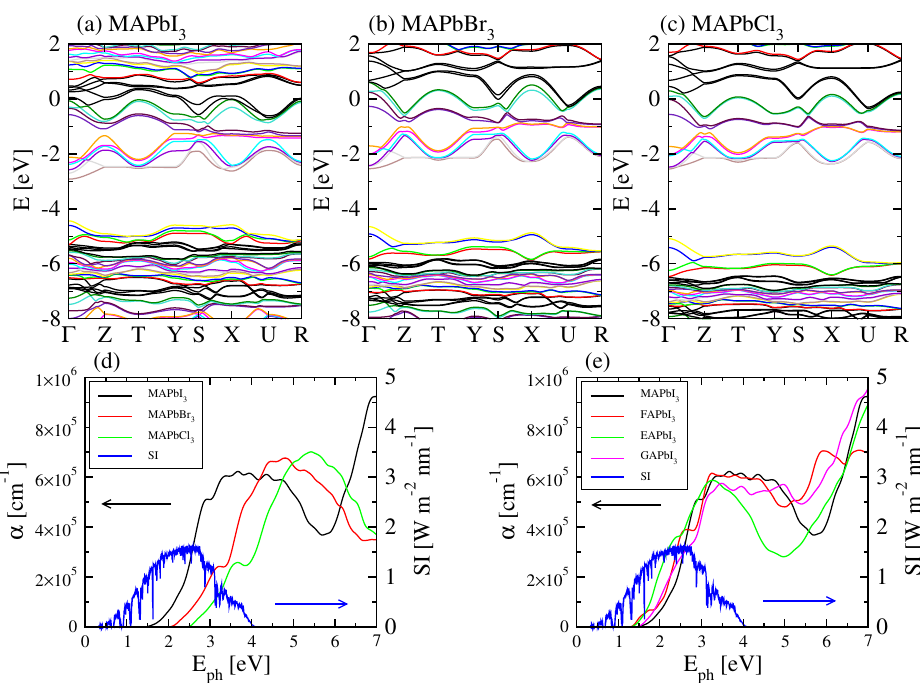
Figure 4. Representative opto-electronic properties. The band structures are indicated for ( a ) MAPbI 3 , ( b ) MAPbBr 3 , ( c ) MAPbCl 3 . The absorption coefficients are depicted comparatively for the different halogens and cations in ( d , e ), respectively. The spectral solar irradiance ( S I ) is also